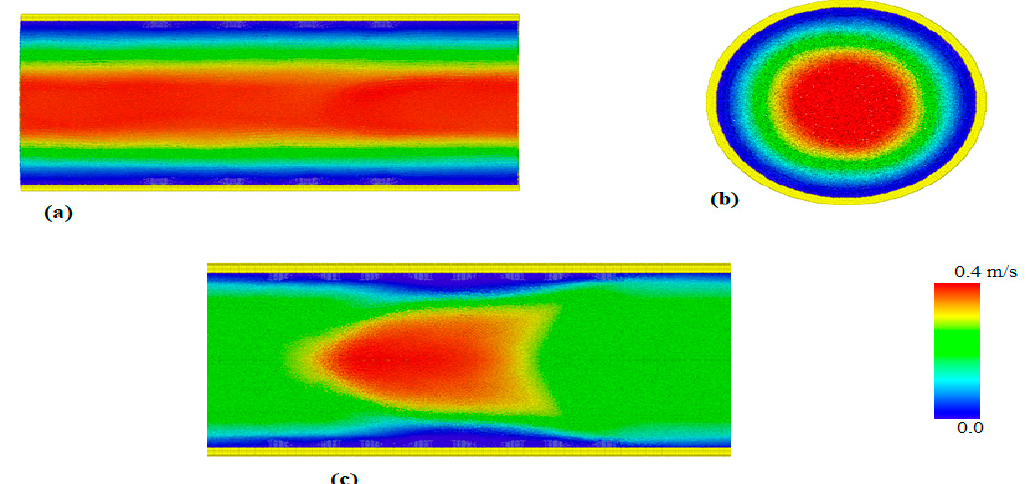
Figure 2. Velocity profile; ( a ) x - y view (steady state profile), ( b ) y - z view, and ( c ) parabolic profile at the beginning of the flow.